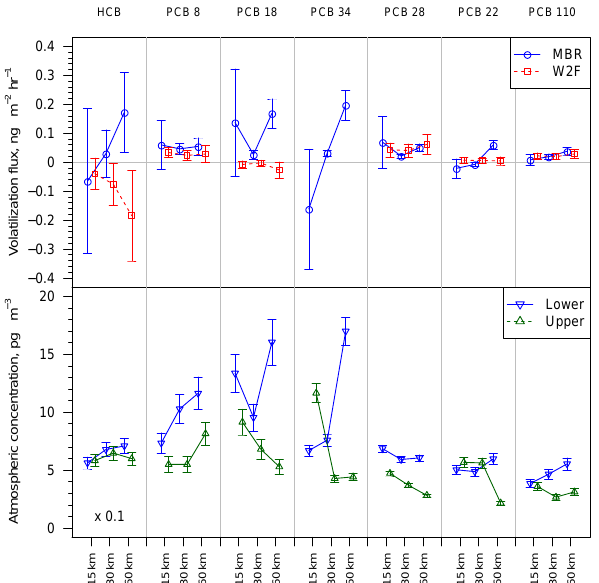
Fig. 2. Overall mass transfer velocity, kol, for each PBT at the 15, 30, and 60km stations.